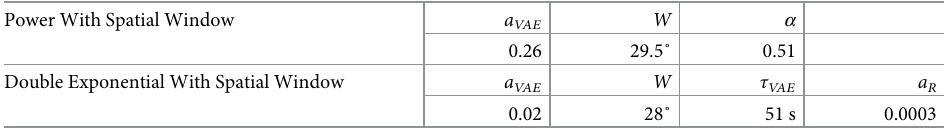
Table 2. Model best fit parameters. Values indicate population median, and were used to produce the model simula- tions in Fig 5B. Power With Spatial Window Double Exponential With Spatial